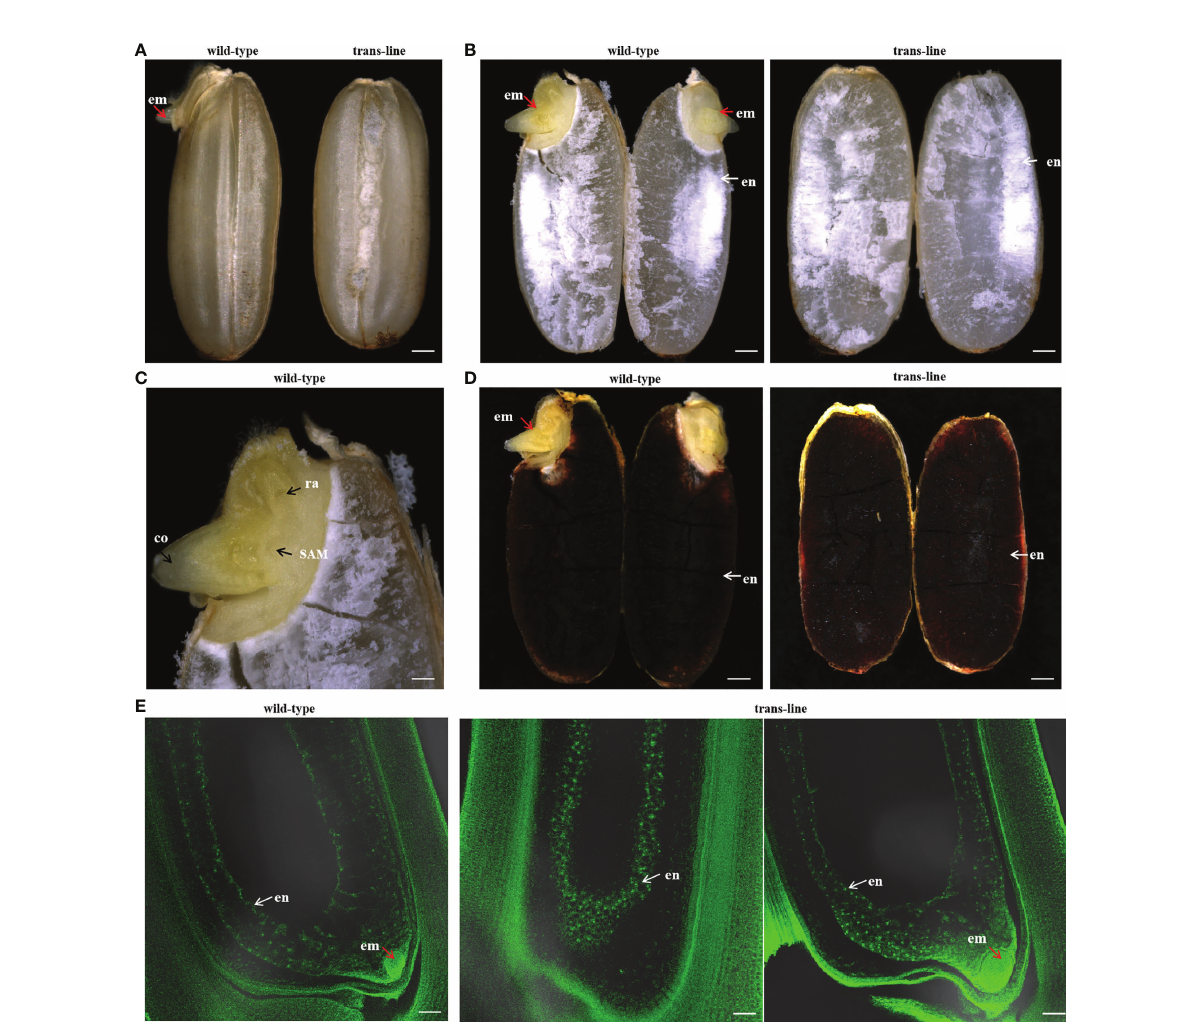
FIGURE 5 Development of embryo-free seeds in transgenic line. (A) Seeds were germinated normally with embryos (left; red arrow) one day after pre- germinated in wild-type 9Y (n=20), but embryo-free seeds without the germination of embryos formation (n=10/10; right) one day after pre- germinated in trans-line. Scale bars, 0.7 mm. (B) Embryo (left; em; red arrow) and endosperm (left; en; white arrow) are observed after a cross- section of seeds in wild-type (n=10; left), but just endosperm (right; white arrow) is observed with embryo-free seeds in trans-line (n=10; right). Scale bars, 0.7 mm. (C) Embryos show normal development in wild-type (n=10), co, coleoptiple; ra, radicle; SAM, shoot apical meristerm. Scale bars, 0.25 mm. (D) Endosperm turned into black when is staining with I 2 -KI in control wild-type (n=10; left) and trans-line(n=10; right). Scale bars, 0.7mm. (E) Development of embryo is not observed in carpels (n=1/20; middle) of the plant in trans-line at 3 days after pollination (DAP), or show normal development (n=19/20; right). In fertilized control wild-type carpels, the development of both embryo and endosperm in carpels (3DAPs) is observed (n=20; left). Scale bars, 35